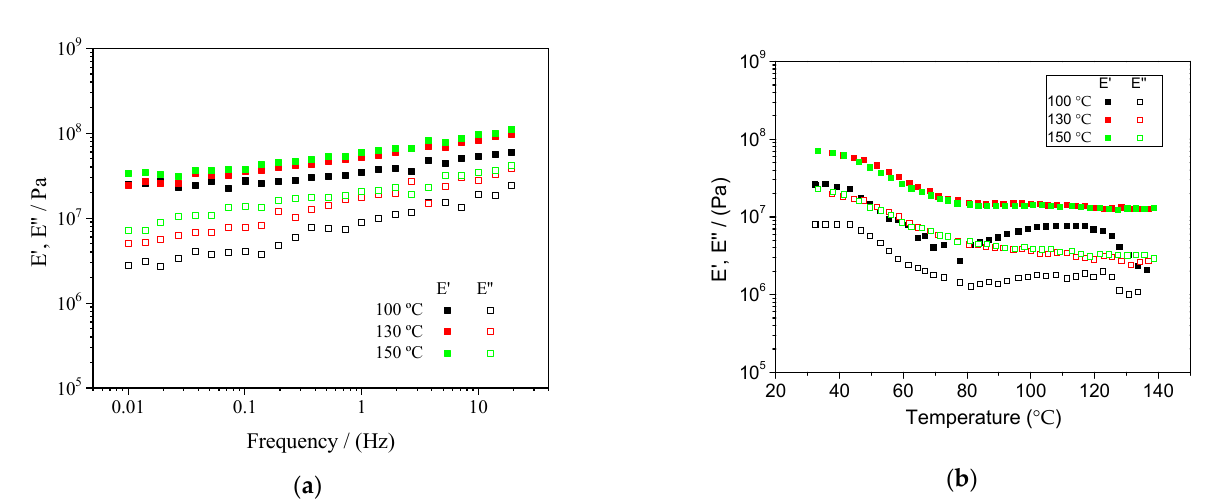
Figure 2. DMTA tests performed on the final bioplastics. ( a ) Frequency sweep tests from 0.01 to 20 Hz at room temperature and ( b ) temperature sweep tests from 30 to 140 ° C at 1 Hz.